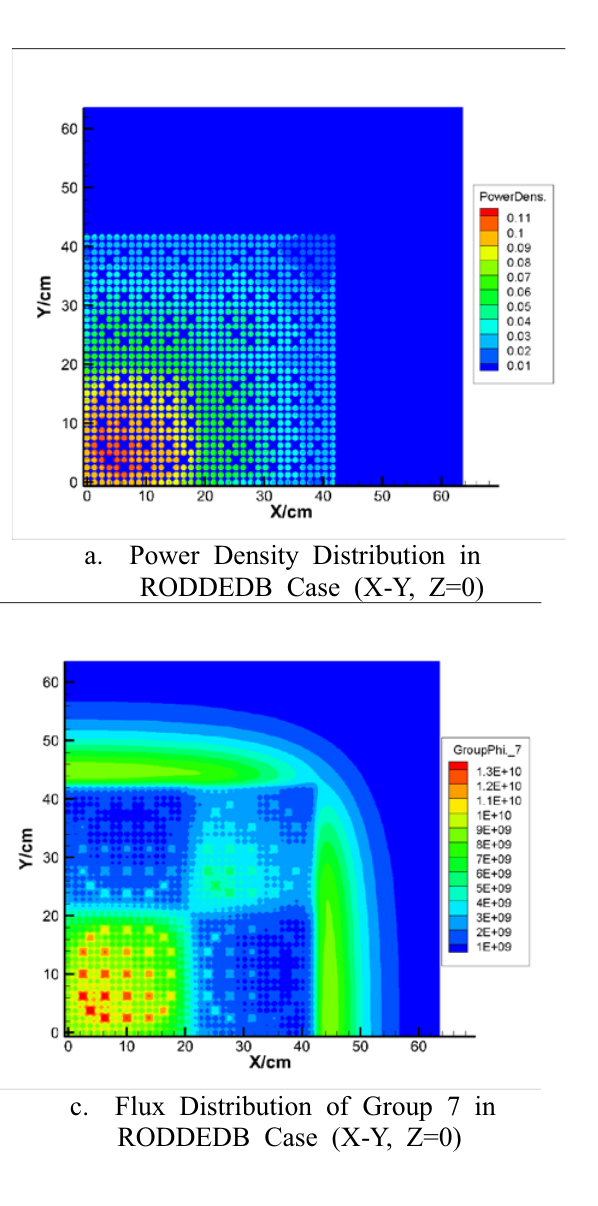
Figure 5. Power Density Distribution and Flux Distribution of Group 7 Form X-Y and Y-Z Cross-Section in RODDEDB